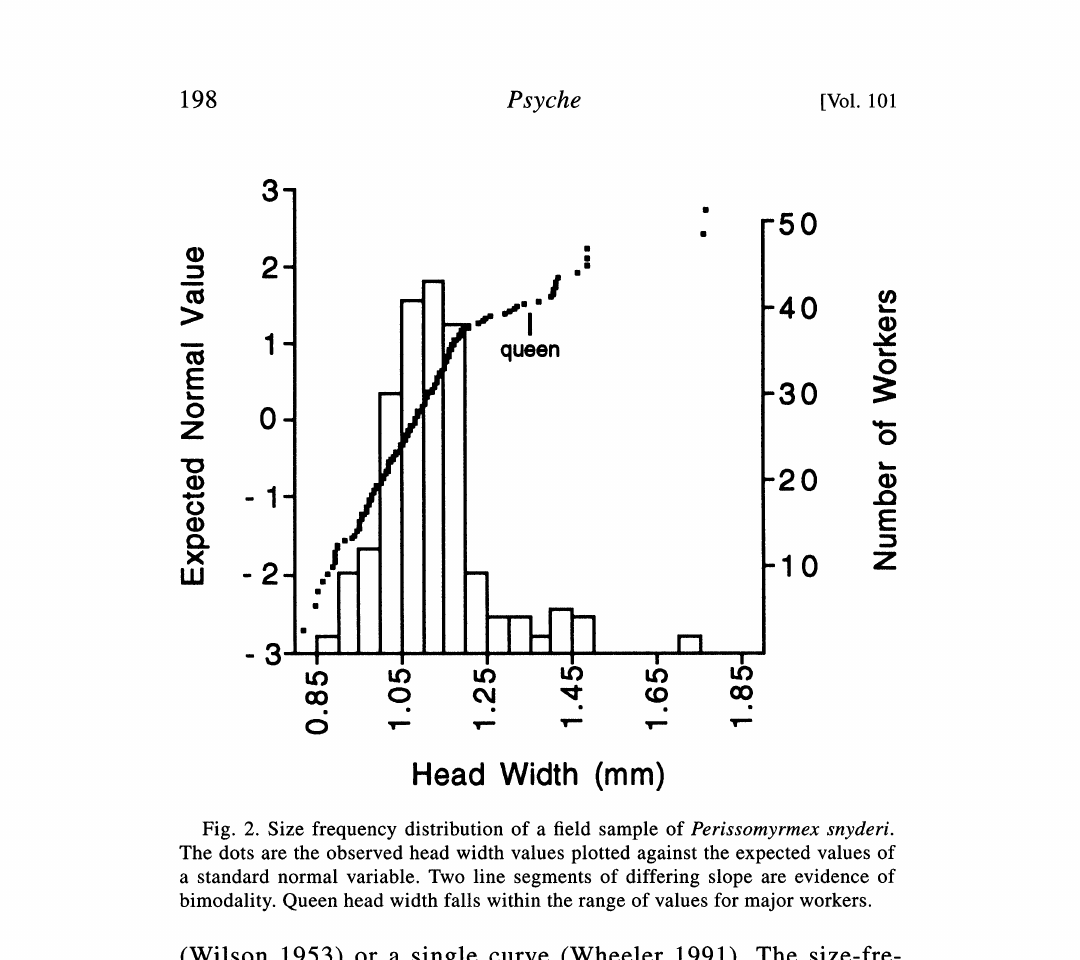
Fig. 2. Size frequency distribution of a field sample of Perissomyrmex snyderi. The dots are the observed head width values plotted against the expected values of a standard normal variable. Two line segments of differing slope are evidence of bimodality. Queen head width falls within the range of values for major